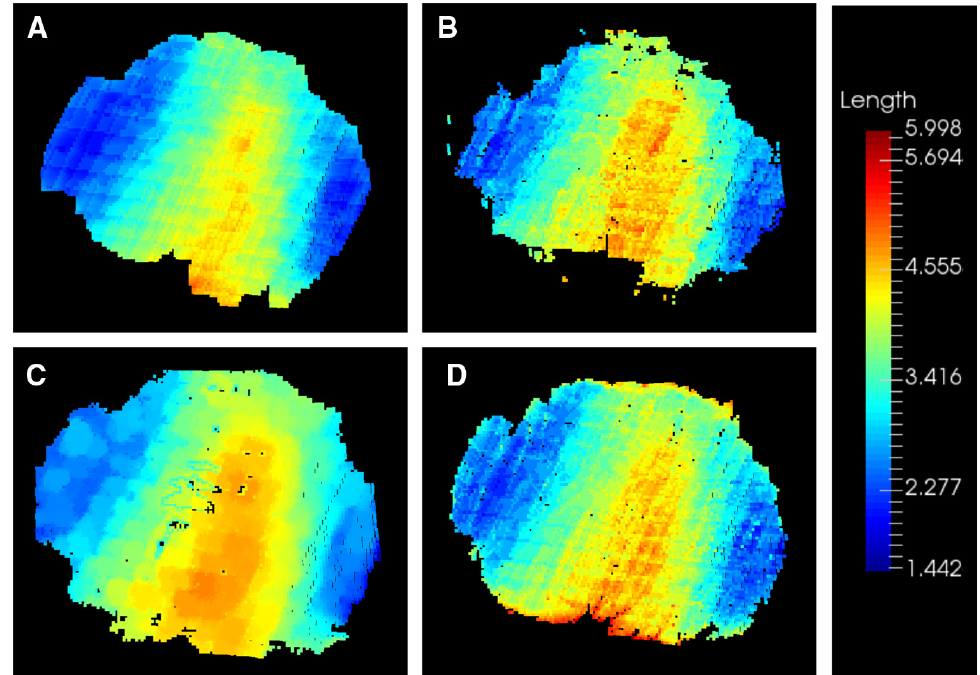
Figure 3: Thickness values (mm) of lateral cartilage projected along the z-axis. All voxels that have been assigned a thick- ness value by the respective method are shown. (A) Nearest neighbor. (B) Surface normals. (C) Local thickness. (D) Field